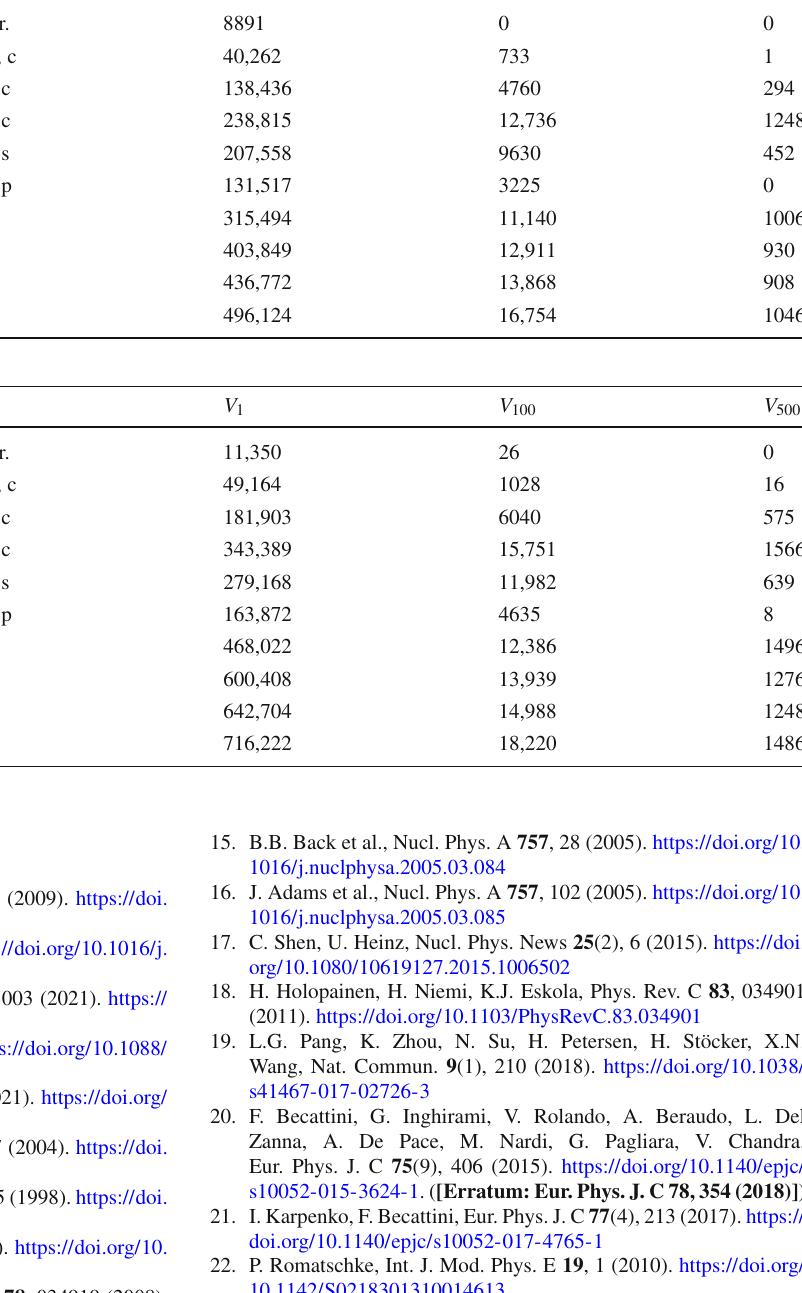
Table 13 Results for X < 0 . 3 and Y < 0 . 3